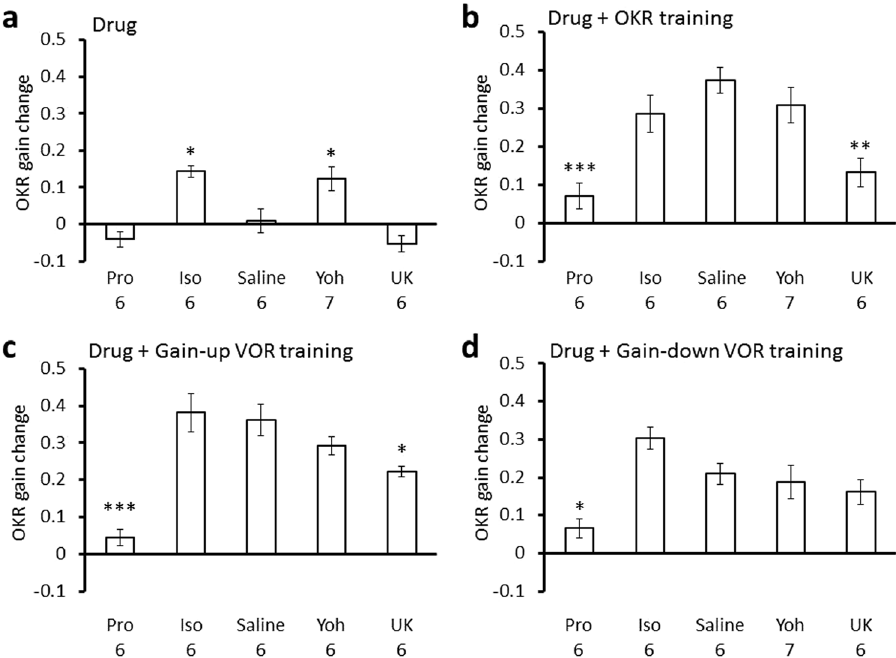
Figure 5. OKR gain changes induced by various treatments. ( a ) Effects of administration of propranolol (Pro), isoproterenol (Iso), saline, yohimbine (Yoh) or UK14304 (UK) on the OKR gain. Pro, Iso and Saline data are same as those shown in Fig. 2g. They are presented again for comparison. ( b–d ) Effects of administration of propranolol, isoproterenol, saline, yohimbine or UK14304 on the OKR gain increase induced by OKR training ( b ), by gain-up VOR training ( c ) or by gain-down VOR training ( d ). Numbers under each graph indicate numbers of mice, and error bars indicate SEM. * p < 0.05, ** p < 0.01, *** p < 0.001, compared with saline- injected control, Dunnett’s